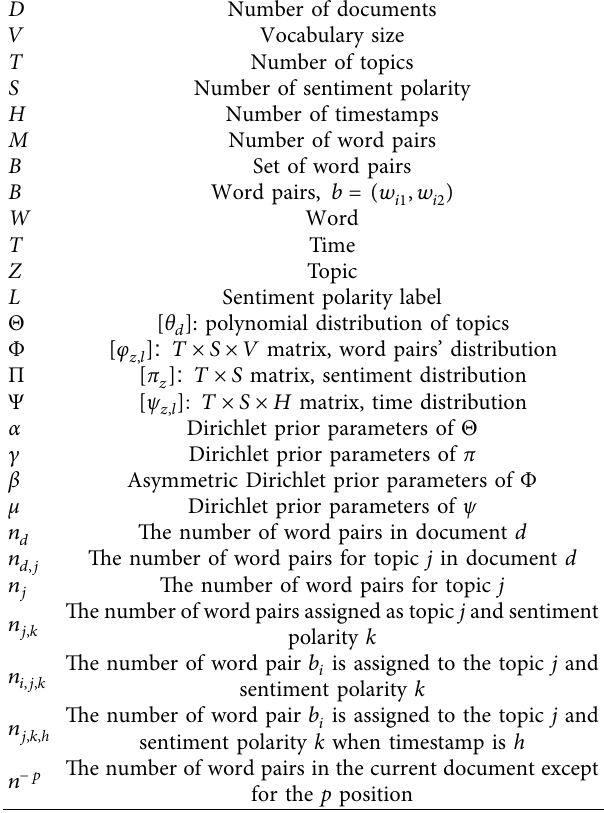
Table 1: Explanation of